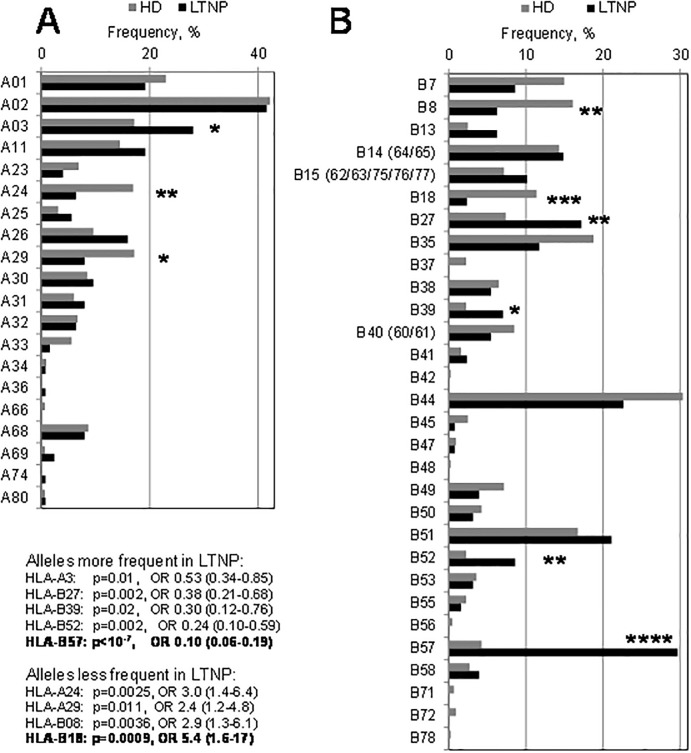
Comparison of the frequencies of HLA-A and HLA-B individuals between LTNP and healthy donor populations.HD, n = 448 donors for HLA-A and HLA-B; LTNP, n = 125 patients for HLA-A and 128 patients for HLA-B. Statistically significant differences are marked with asterisks (*, p<0.05; **, p<0.01; ****, p<0.0001) and detailed in the text inset. Relevant frequencies for HD vs. LTNP are: HLA-A03 (17 vs. 28%), HLA-A24 (17 vs 6.4%), HLA-A29 (17 vs. 8.0%), HLA-B8 (16 vs. 6.3%), HLA-B18 (11 vs 2.3%), HLA-B27 (7.4 vs. 17%), HLA-B39 (2.2 vs. 7.0%), HLA-B52 (2.2 vs. 8.6%) and HLA-B57 (4.2 vs. 30%).